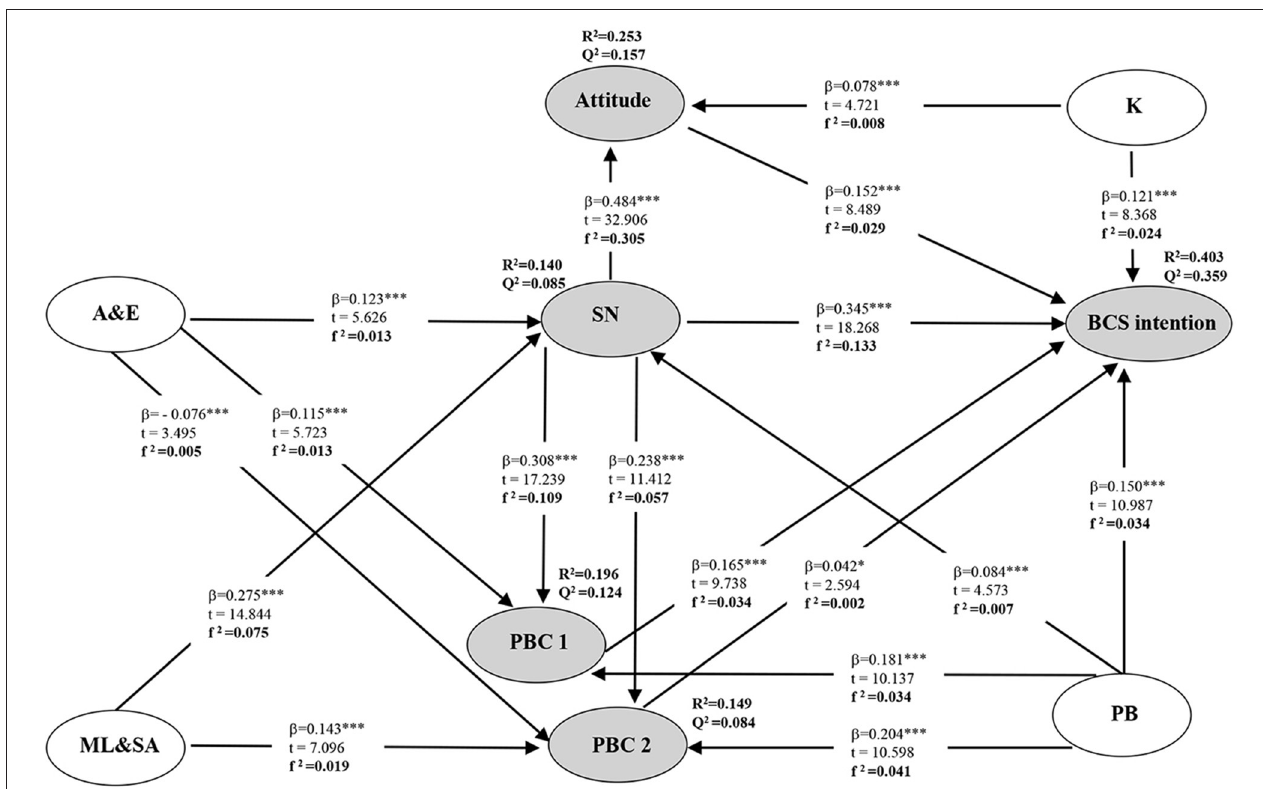
FIGURE 3 | A path diagram for the research model. β , path coefficient; *** p < 0.001, * p < 0.05; t, t -value; R 2 , coefficient of determination, which represents the amount of explained variance of each endogenous latent variable; f 2 , effect size; Q 2 , predictive relevance; PB, past behavior; BI, behavior intention; PBC1, perceived behavioral control 1; PBC2, perceived behavioral control 2; SN, subjective norm; K, knowledge; ML&SA, the medical level and service attitude; A&E, advocacy and education; BCS intention, breast cancer screening